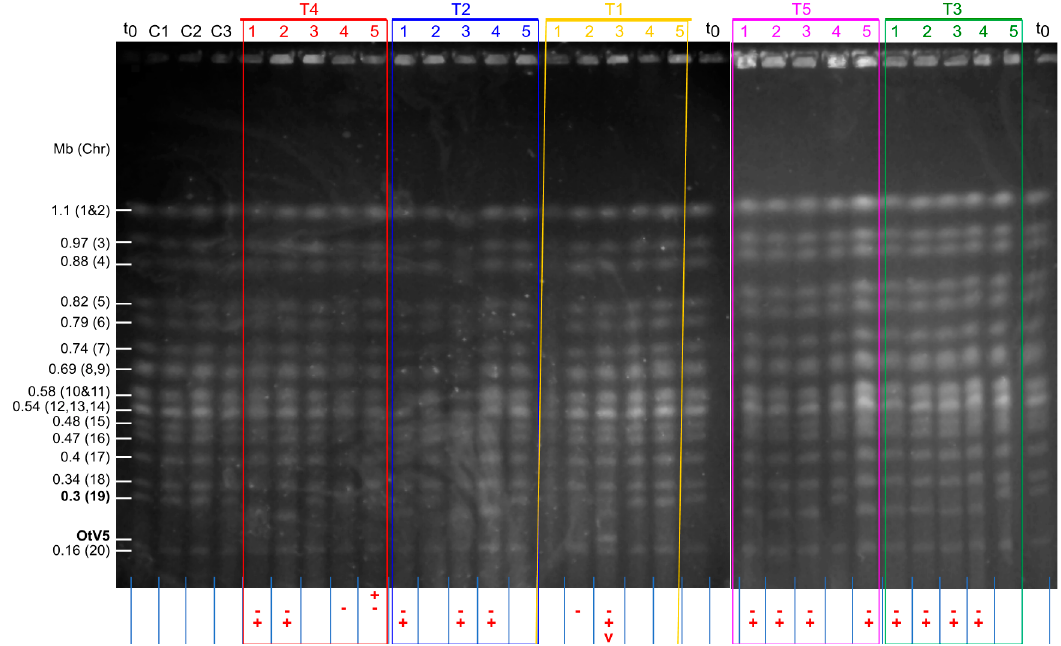
Figure 3. Karyotypes of clonal lines O. tauri visualised by PFGE separation of the chromosomes. The figure is a composite of two separate gels. t 0 : wild-type O. tauri RCC4221 the start of the experiment. C1 , C2 , and C3 : clonal lines established from mock-inoculated control cultures. T1–T5 : Five independent clonal lines were established from each of the Test (T1–T5) OtV5-resistant cultures shown in Figure 2, i.e., five lines from each of the five cultures (labelled and boxed with similar colours in both figures). Annotations underneath the gel tracks show which tracks have bands with altered mobilities. - : absence of chromosome 19 at its expected mobility (0.3 Mb, indicated position in bold on the left) in test cultures. + : presence of a chromosomal band not detected in Control cultures. v : presence of the OtV5 viral genome (184 kb long) in inoculated cultures.